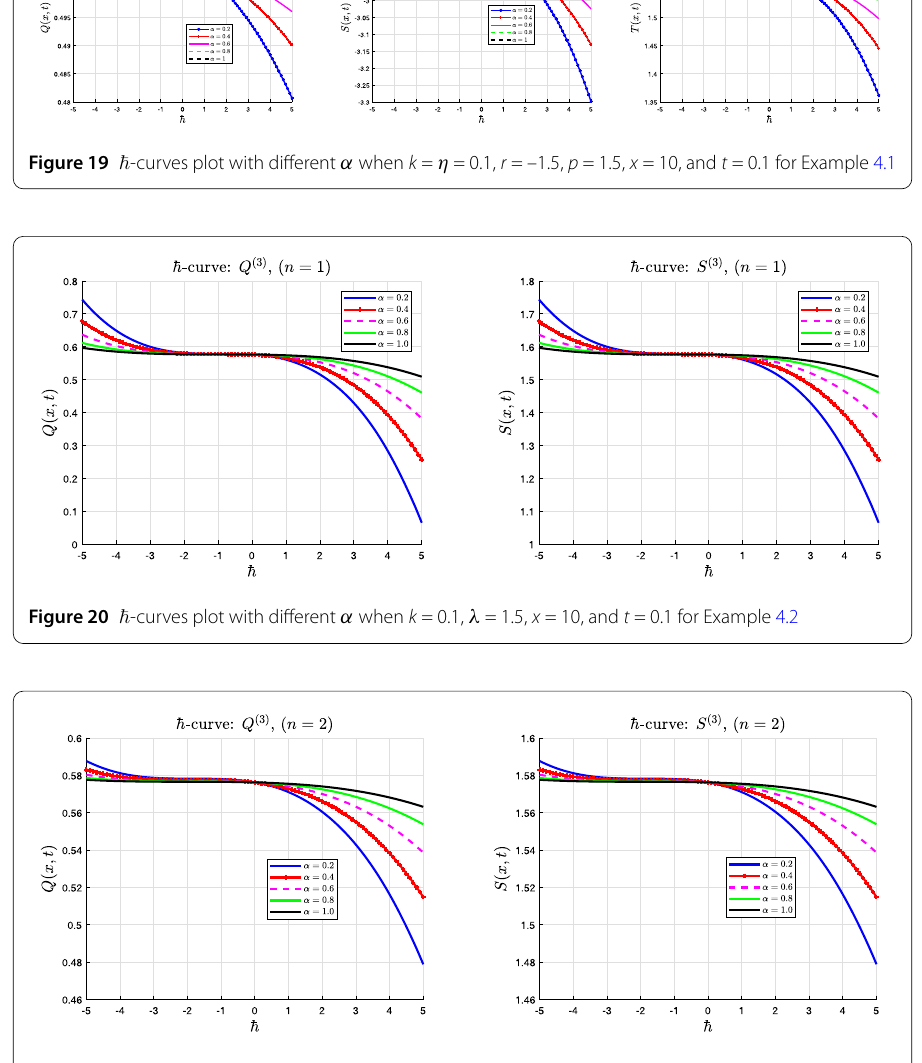
Figure 21 (cid:2) -curves plot with different α when k = 0.1, λ = 1.5, x = 10, and t = 0.1 for Example